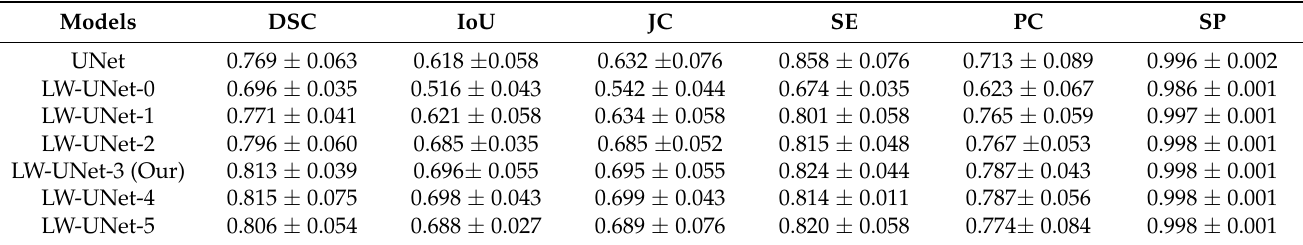
Table 2. The ablation analysis validates the effectiveness of our model configuration.